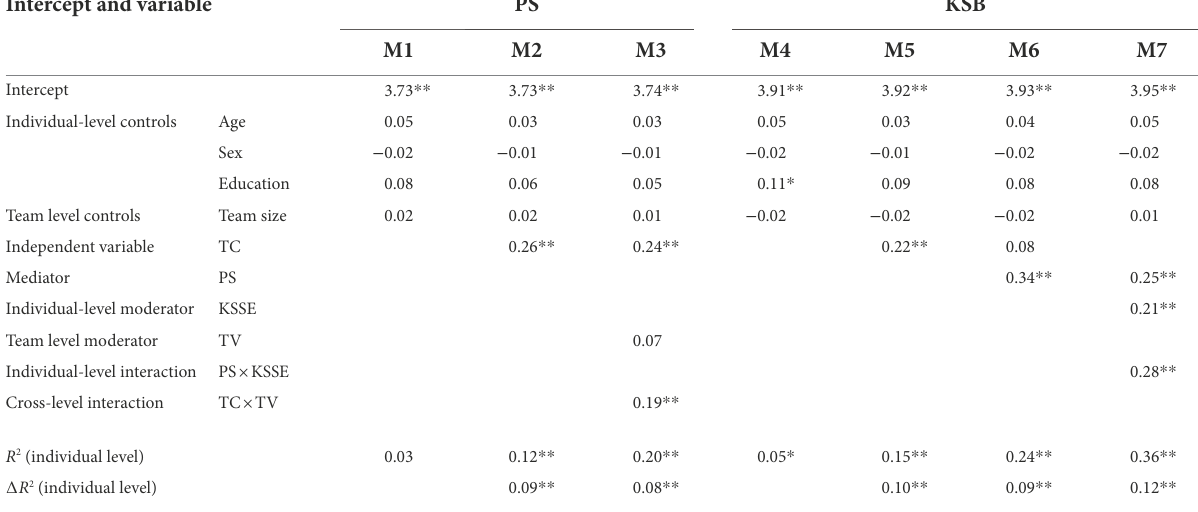
TABLE 3 Hierarchical regression results.